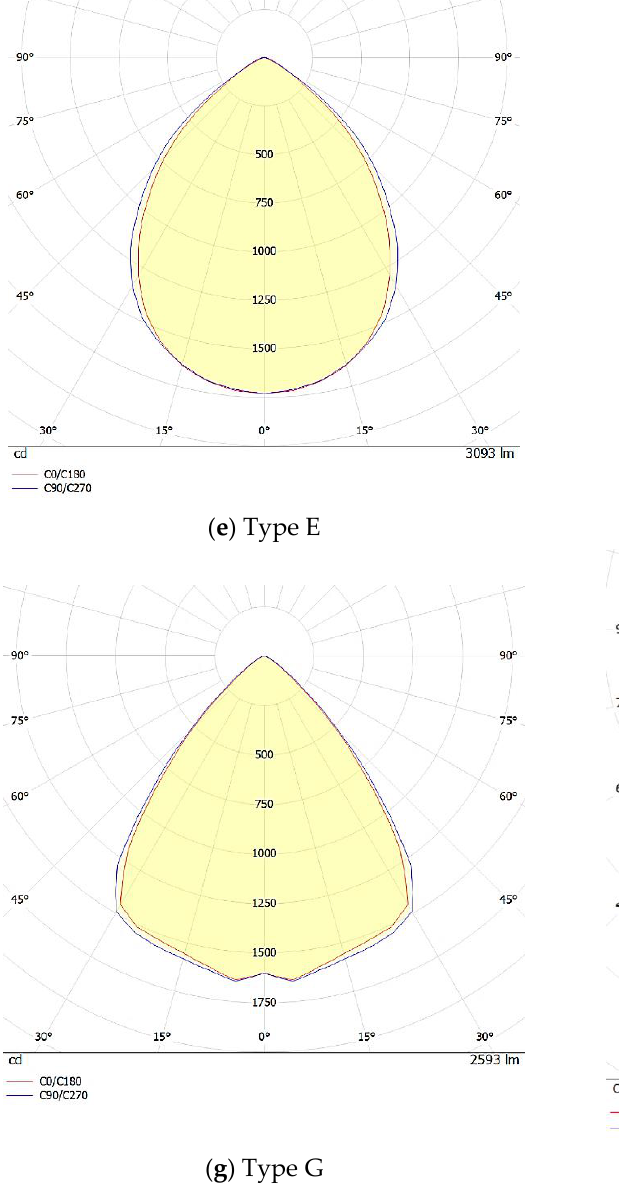
Figure 9. ( a – h ). (Luminaires types A – H) Luminous intensity distribution of eight luminaires with lenses studied in this research.